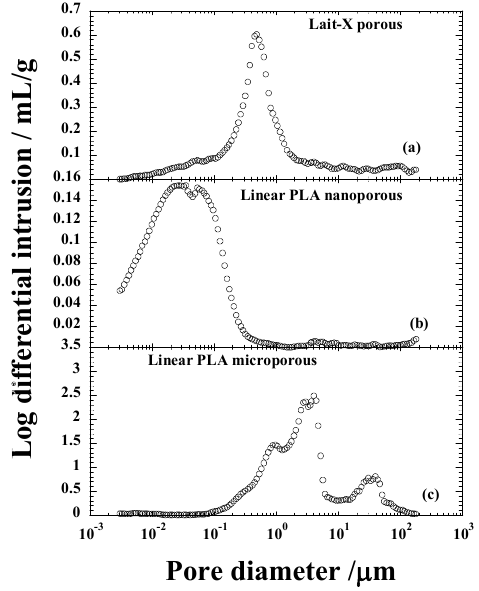
Figure 4. Pore size distribution of ( a ) Lait-X having a porous structure; ( b ) linear polylactide (PLA) having a nanoporous structure; and ( c ) linear PLA having a microporous structure before